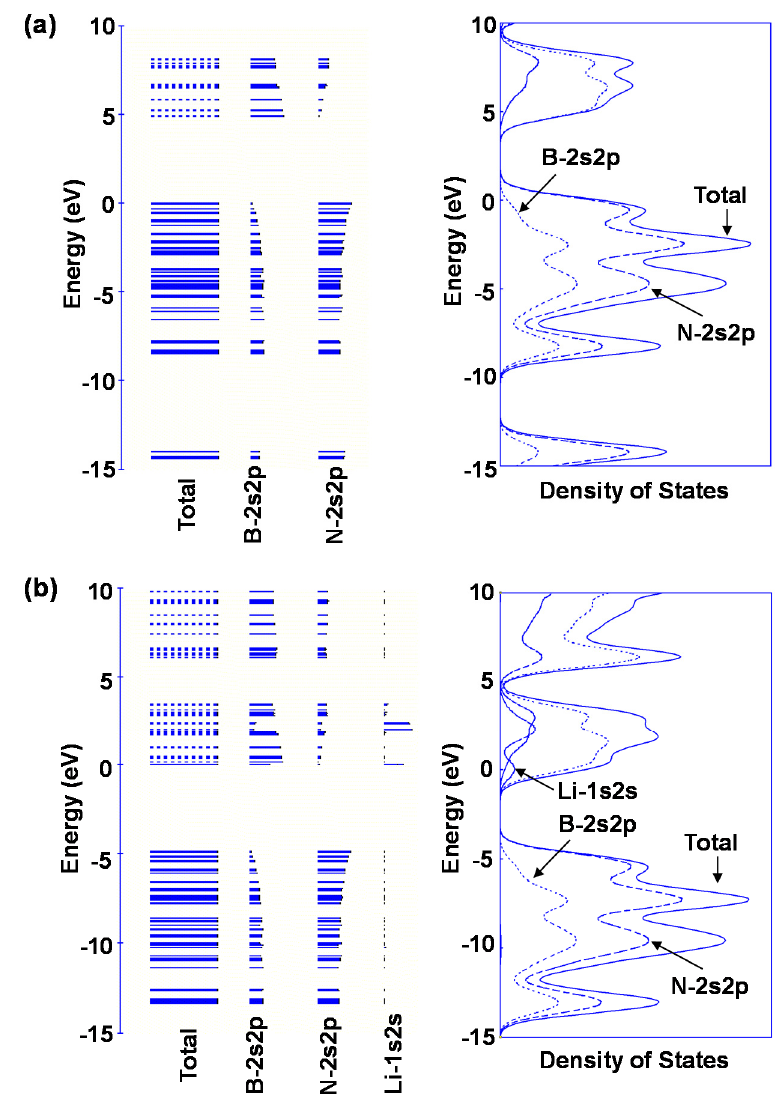
Figure 10. Energy levels diagrams and density of states of ( a ) B 24 N 24 and ( b ) Li@B 24 N 24